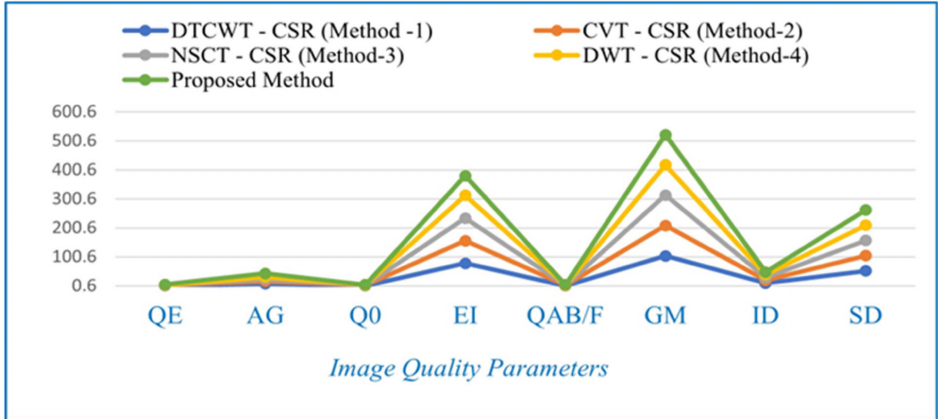
Figure 29. Evaluation of different fusion methods for different parameters based on them average